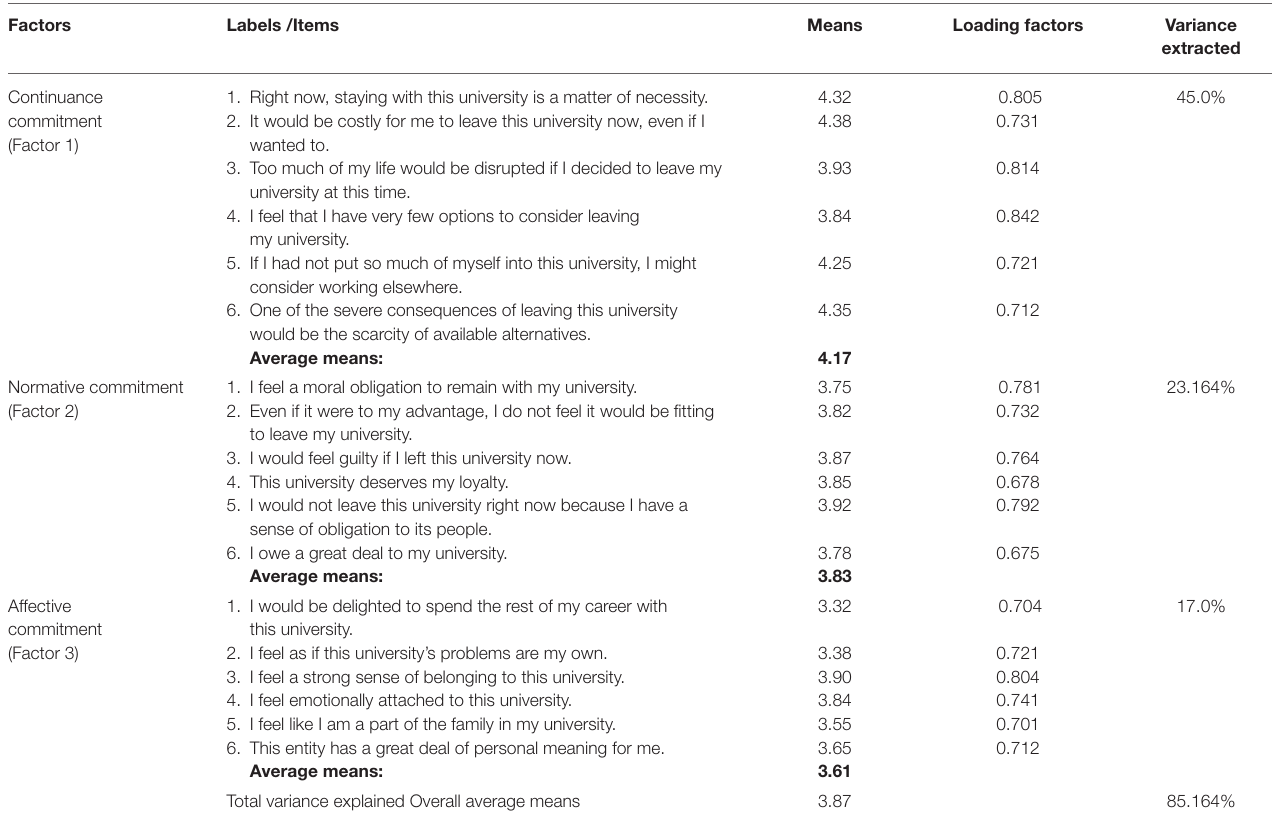
TABLE 1 | Loading factors of construct. Factors Labels /Items Means Loading factors Variance